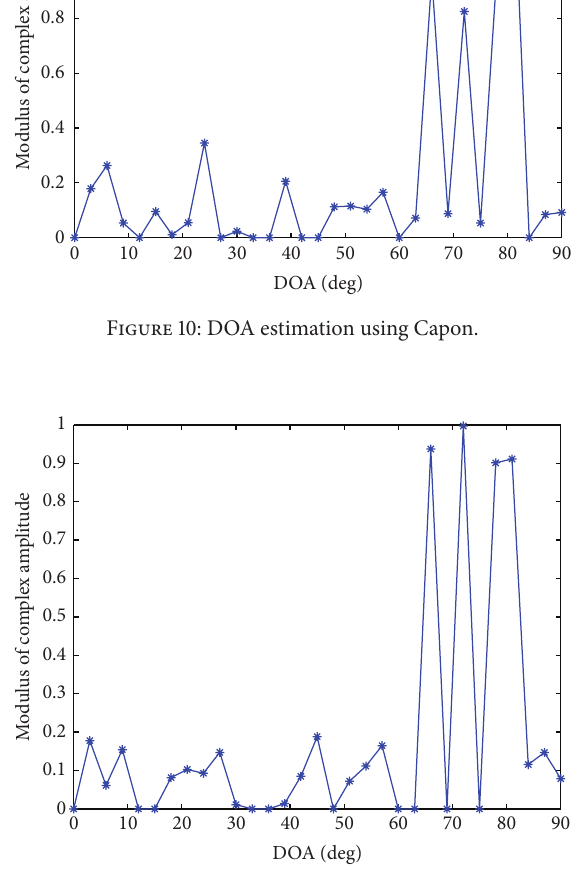
Figure 11: DOA estimation using APES.